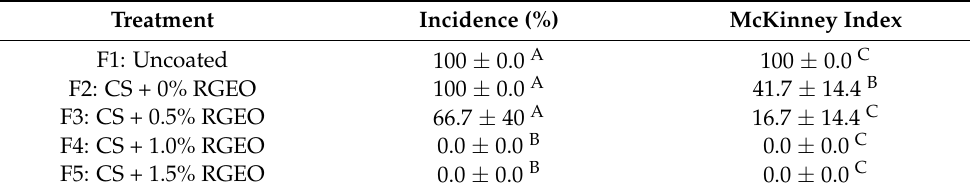
Table 2. Damage incidence and McKinney index of weight in pears with CS + RGEO to the final day of storage